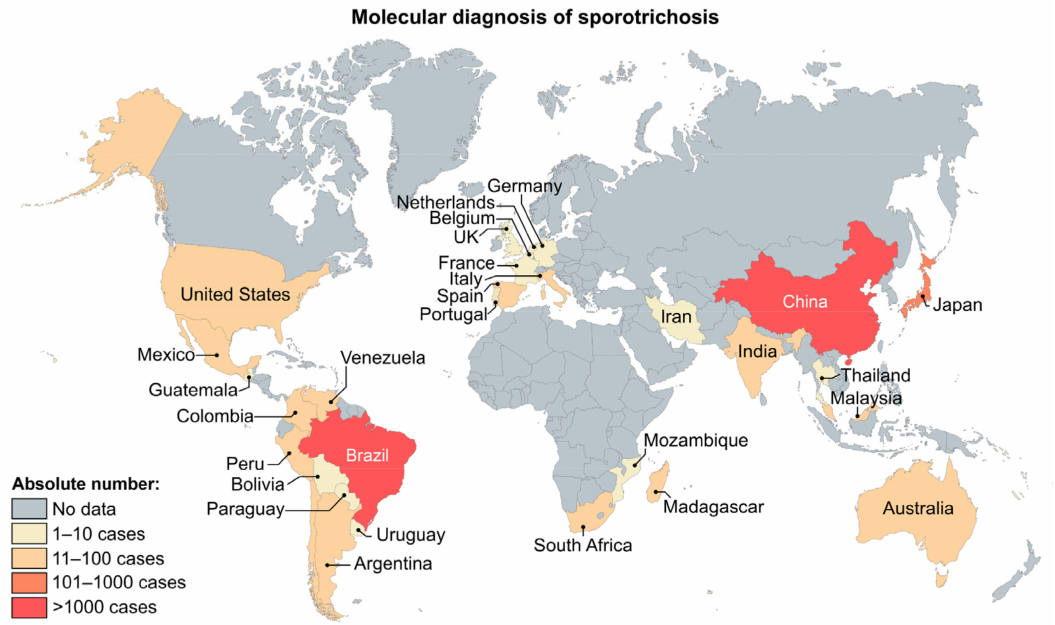
Figure 8. Distribution of sporotrichosis cases diagnosed by molecular assays globally from 2007 to 2020. According to molecular-based characterization, the distribution patterns observed show that Brazil and China are the predominant endemic regions to perform molecular diagnosis of sporotrichosis. References of the molecular epidemiological data for the methodology are available in Supplementary Table